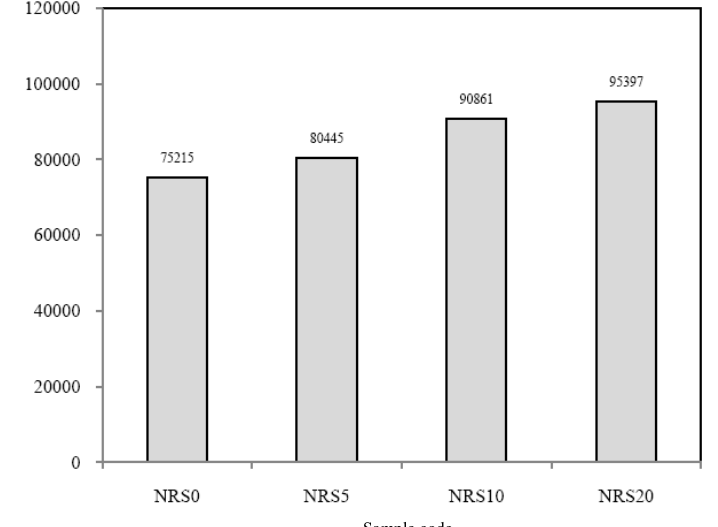
Figure 11. Fatigue life of samples at various silica